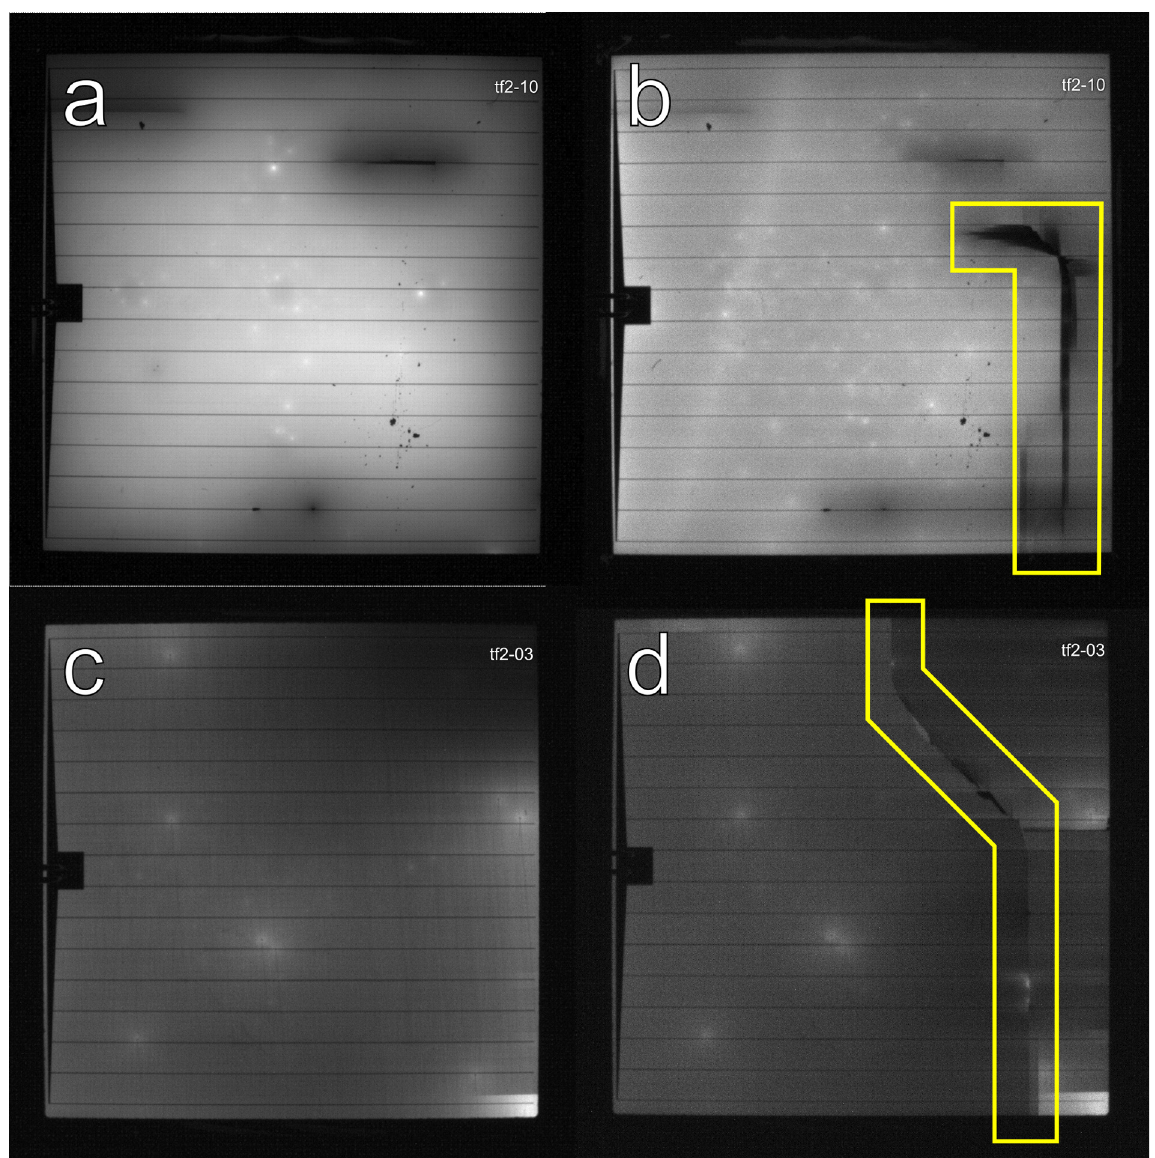
Fig. 3. Spatial electroluminescence measurements of two IMM4J solar cells before (a & c) and after (b & d) electron irradiation. In all four images a few shunts (bright spots) are observable and after electron irradiation huge cracks (yellow marking) were formed due to the amount of handling step of this thin fi lm